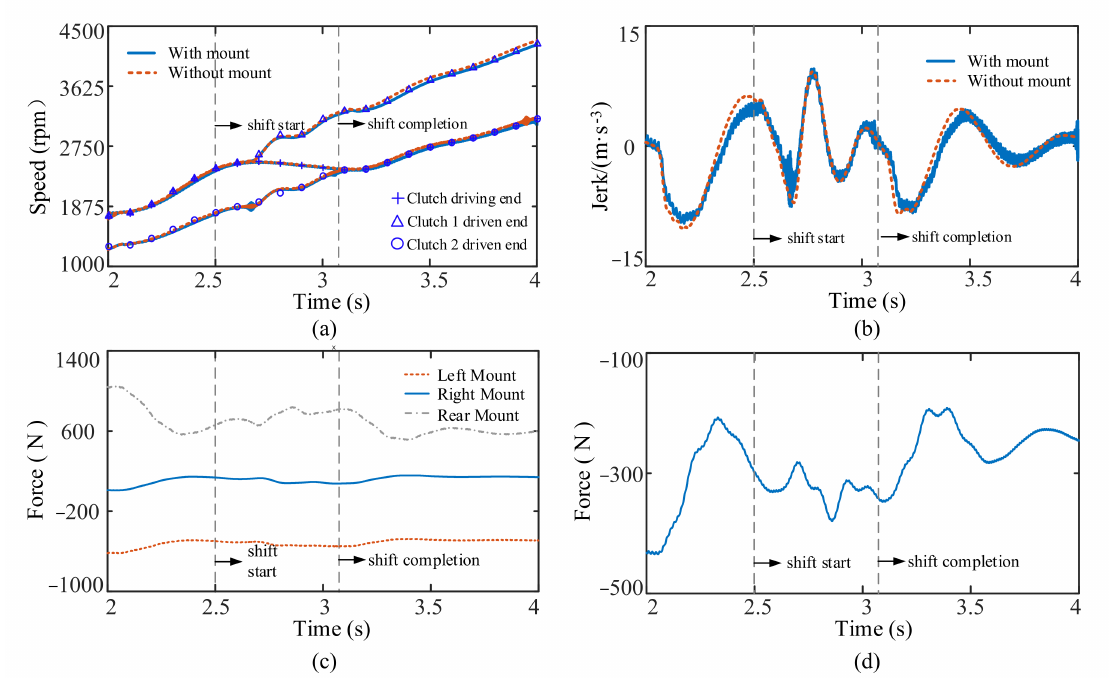
Figure 7. The results of the mount influence on the shifting condition: ( a ) clutch driving end and driven end speed; ( b ) vehicle jerk; ( c ) longitudinal force of each mount; ( d ) the longitudinal force of the powertrain through the